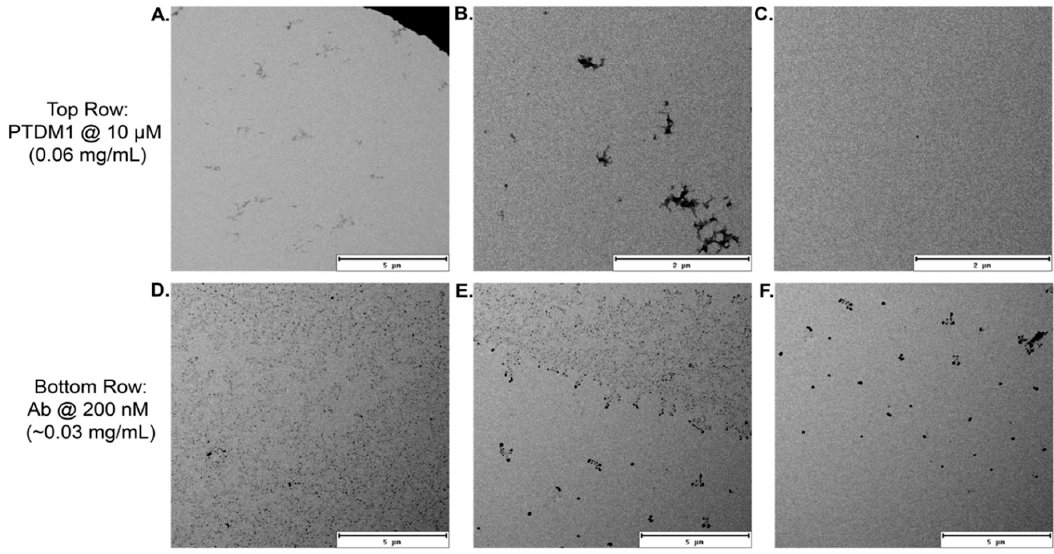
Figure 3. Transmission electron microscopy (TEM) micrographs of PTDM1 ( A – C ) and IgG-FITC whole antibody (Ab) ( D – F ) solvent cast from Milli-Q ® Water at 10 µM for PTDM1 and at 200 nM for the Ab on TEM grids which were dried in ambient conditions overnight. ( A ) Large area image of PTDM1 in focus showing large drying artifacts. ( B ) Large area image of PTDM1 at 2.50 µm under focus showing large, medium, and small drying artifacts. ( C ) Large area image of PTDM1 at 2.50 µm under focus showing a small drying artifact. ( D ) Large area image of Ab at 2.96 µm under focus showing an abundance of aggregated material. ( E ) Large area image of Ab at 2.94 µm under focus showing a sparser region of aggregated material. ( F ) Large area image of Ab in focus showing large drying aggregates.